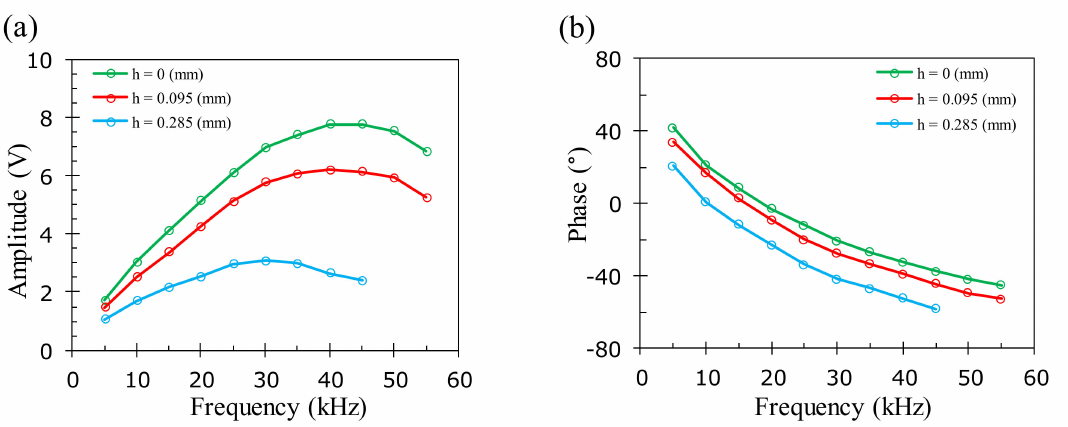
Figure 14. The amplitude and phase response of the EC signals on a crack with a 0.5 mm width and 1.5 mm depth buried at h = 0, 0.095, and 0.285 mm on the aluminum plate with increasing frequencies. ( a ) Peak amplitude and ( b ) corresponding